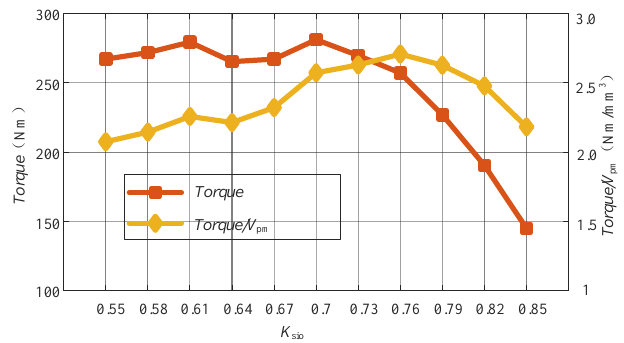
Figure 3. Relationship between torque and split ratio of FSPM generator.